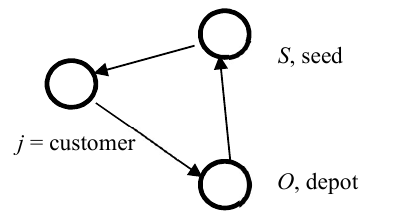
Fig.4. Demonstration of visiting a customer